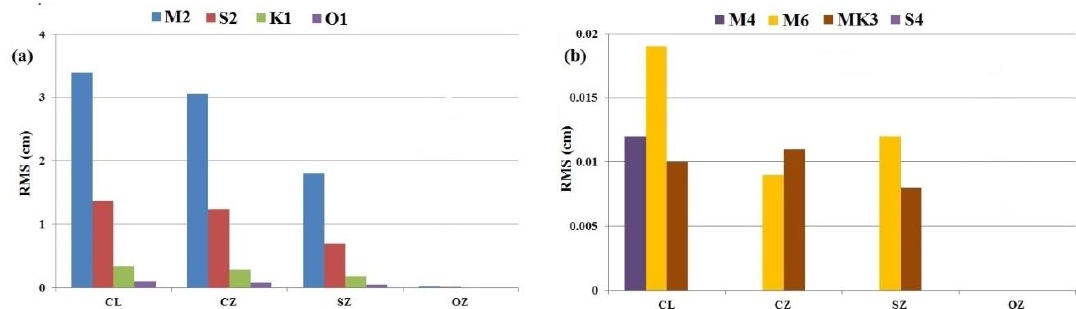
Figure 6. The mean RMS values of the difference between two models, developed based on constant and varying drag coefficient value, in estimated four major ( a ) and four shallow water ( b ) constituents. The values over Ocean Zone (OZ) are equal or close to zero.